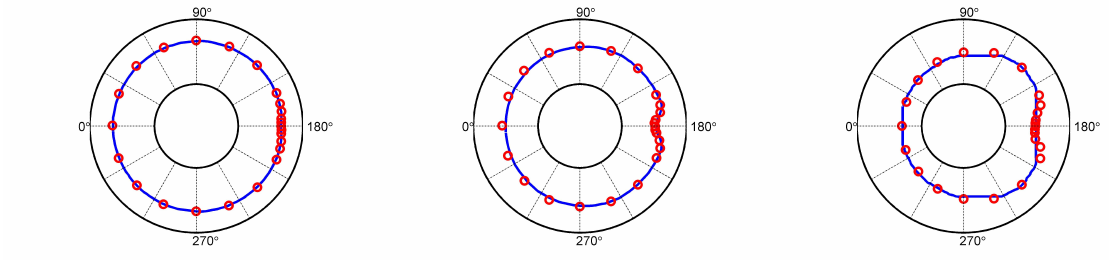
Figure 12. Comparisons of the maximum wave runup between the simulation and measurement for runup of a solitary wave on a circular island. Left, middle, right panels represent the relative wave height at condition H / d = 0.045, 0.096, and 0.181,